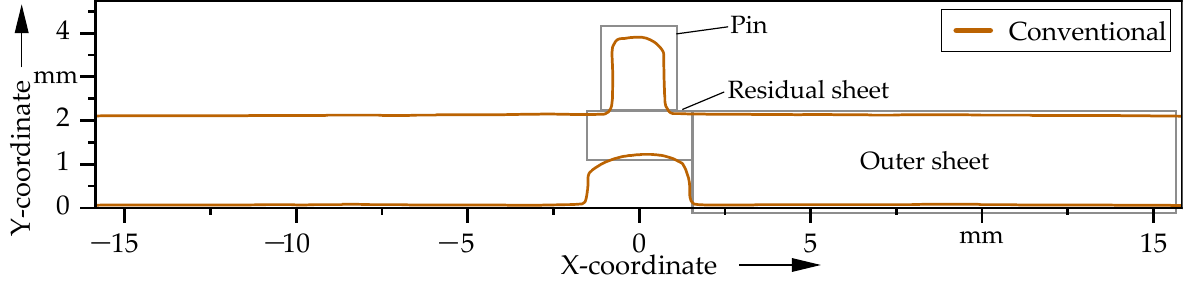
Figure 3. Surface contour of a pin structure extruded from the conventional DC04 sheet with a thickness t 0 = 2